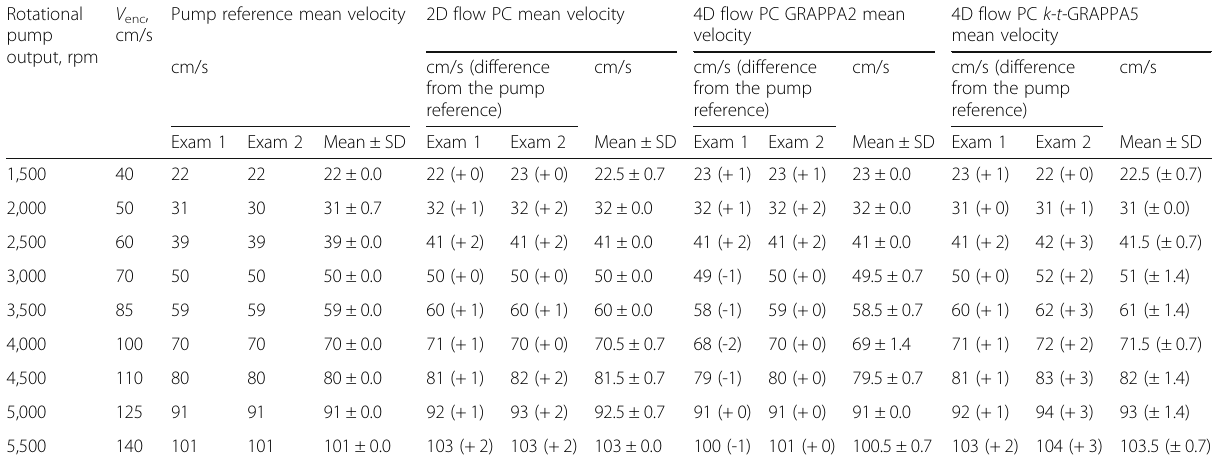
No significant differences between measurements and pump reference were observed ( p = 0.998) 2D two-dimensional, 4D four-dimensional, cm/s centimetres per second, GRAPPA generalised autocalibrating partially parallel acquisition; PC phase- contrast, SD standard deviation of the mean, V enc velocity